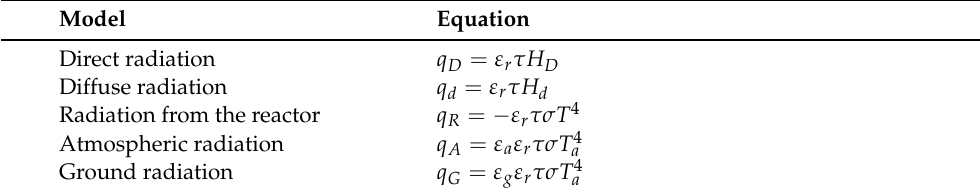
Table 14. Area-specific radiative flux densities, derived from [110]. The meaning of the quantities are H D : intensity of direct radiation at the surface, H d : intensity of diffuse radiation at the sur- face, T : liquid temperature, T a : air temperature, ε r : emissivity of the liquid, ε a : emissivity of